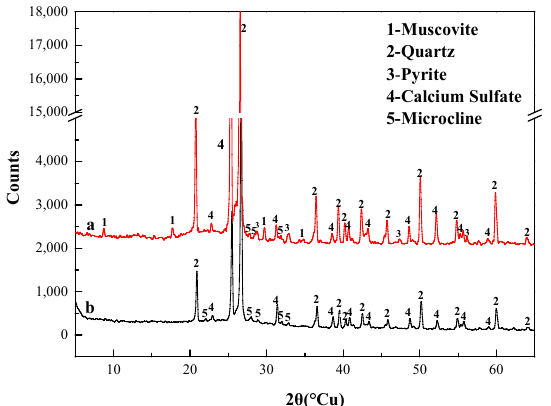
Figure 10. XRD patterns of the NLR ( a ) and the KLR ( b ) obtained after leaching with 4 mol/L H 2 SO 4 and 7 wt% K 2 SO 4 at 150 °C for 5 h.